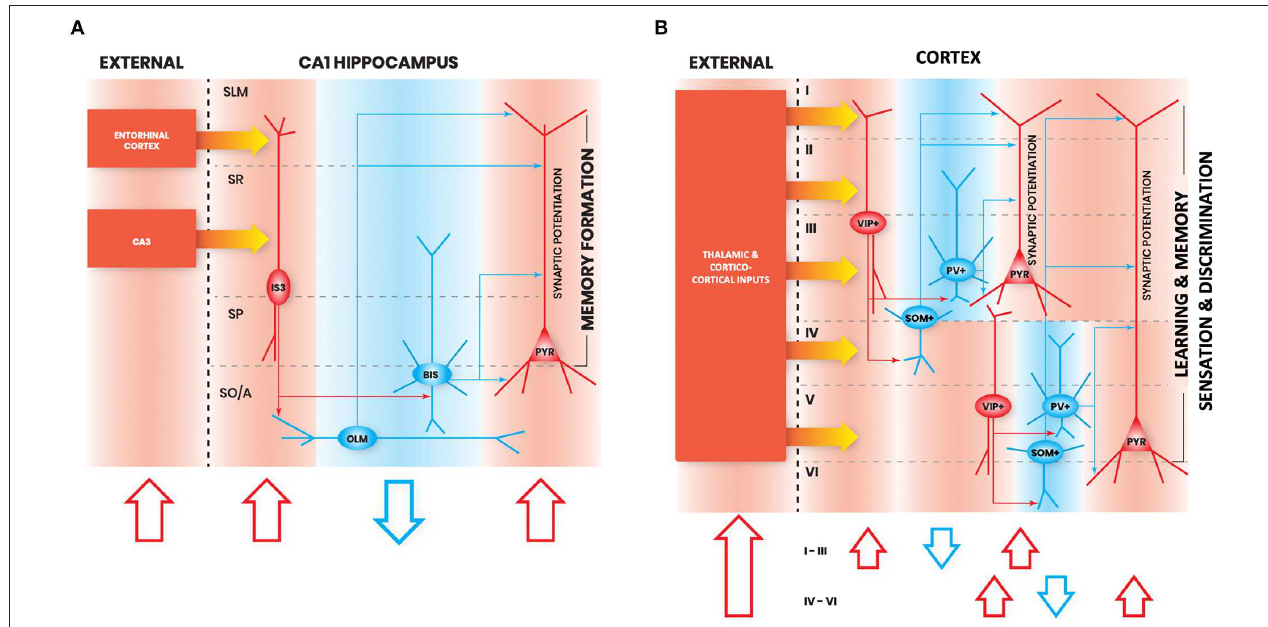
FIGURE 1 | Interneuron-specific cell circuitry across cortical areas allows disinhibition and synaptic potentiation of pyramidal cells via external inputs. In these schematic figures, we highlight the commonalities in I-S circuitry across (A) CA1 hippocampus, and (B) neocortex. We chose to provide illustrations for these brain regions because enough details on I-S cell circuitry in these areas have been reported in the literature. Red shapes denote increased neural activation, and blue shapes denote decreased neural activation. The flow of each schematic is the following: increased activation of excitation from external inputs (1st red arrow) increases activation of I-S cells (2nd red arrow), which decreases activity of other local SOM + and PV + cell types (blue arrow), and allows an increase in gain in pyramidal cells (3rd red arrow). In principle, this can be generalized as the basic mechanism through which activation of I-S cells in different brain areas can lead to enhancements in learning, memory, and sensory discrimination. SO/A, Stratum Oriens/Alveus; SP, Stratum Pyramidale; SR, Stratum Radiatum; SLM, Stratum Lacunosum Moleculare; PYR, Pyramidal